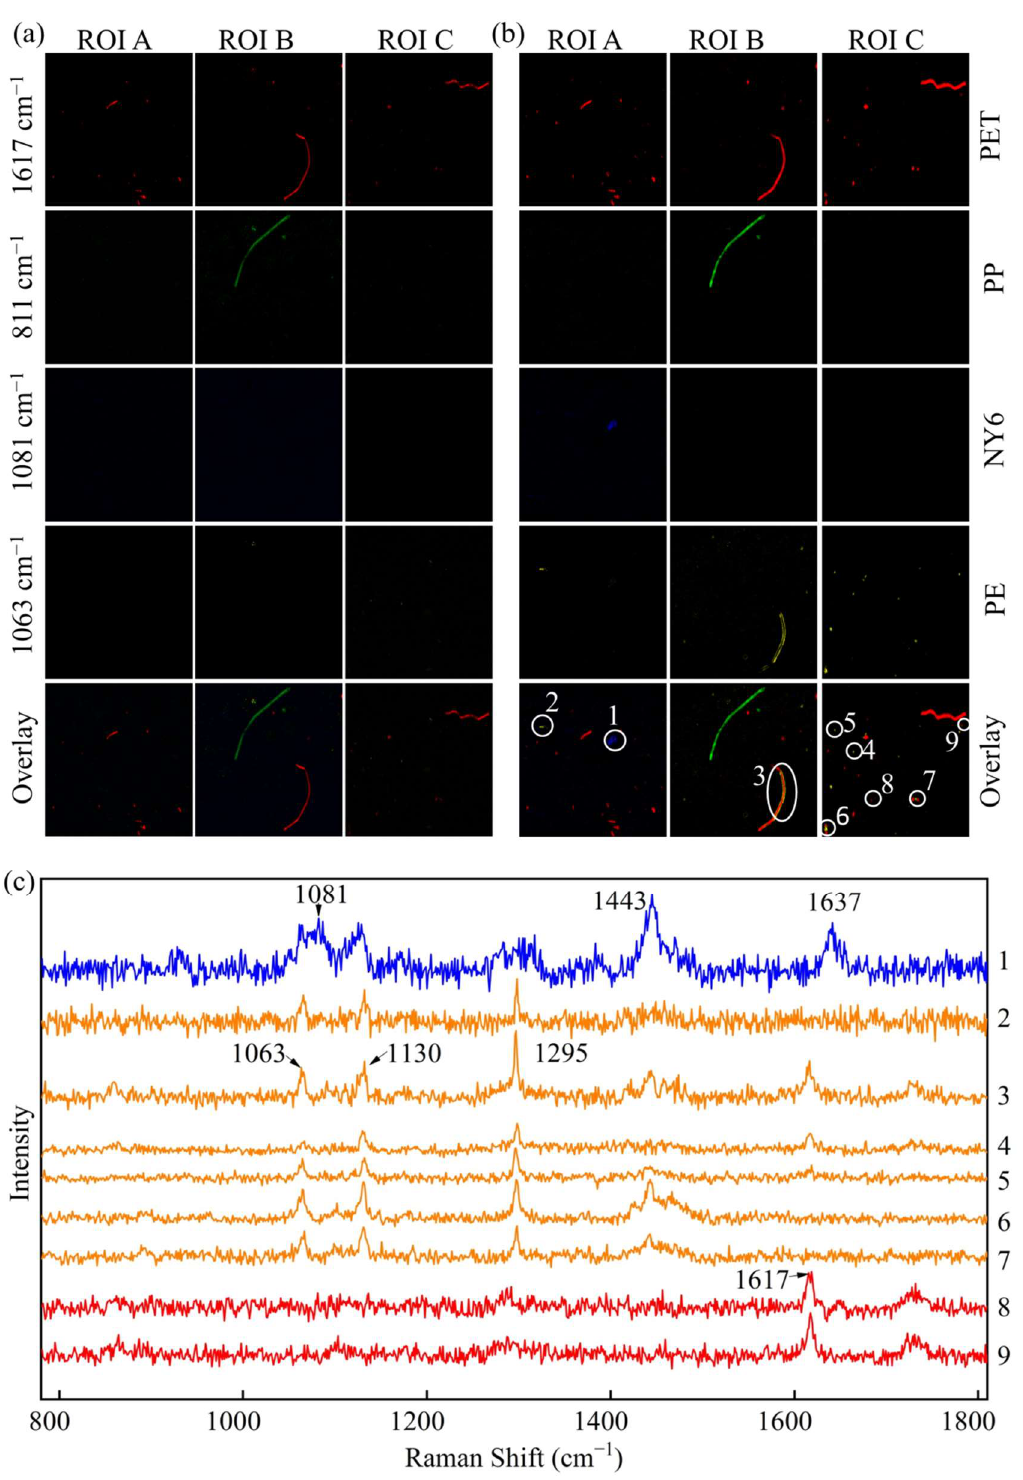
Figure 4. ( a ) Individual Raman maps and overlaid maps obtained by peak area imaging at different characteristic peaks, ( b ) individual Raman maps and overlaid maps obtained by the DCLS method, ( c ) extracted Raman spectra from the circled areas. ( c ) extracted Raman spectra from the circled